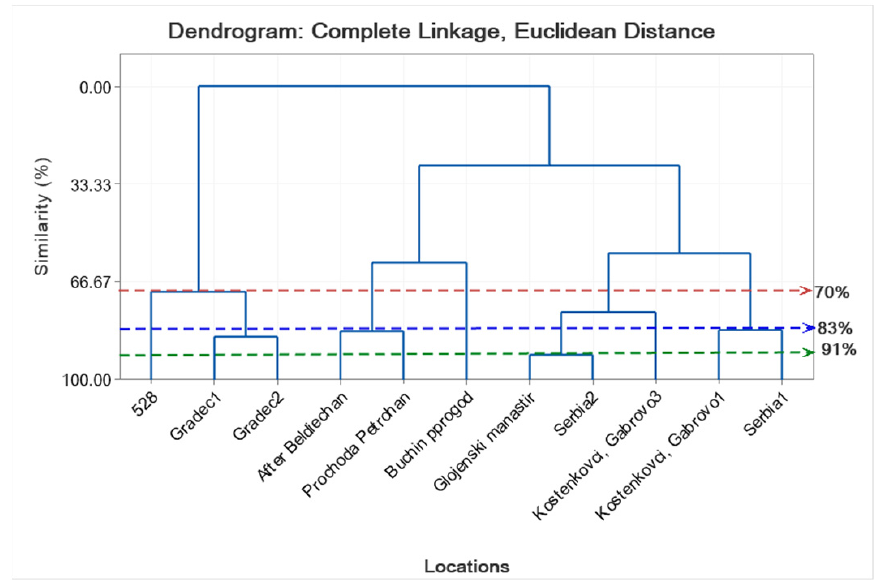
Figure 1. Complete linkage dendrogram showing the similarity of 11 locations in terms of p -cymene, endo -borneol, trans -caryophyllene, spathulenol, and caryophyllene oxide of S. kitaibelii and S. montana (number 528).